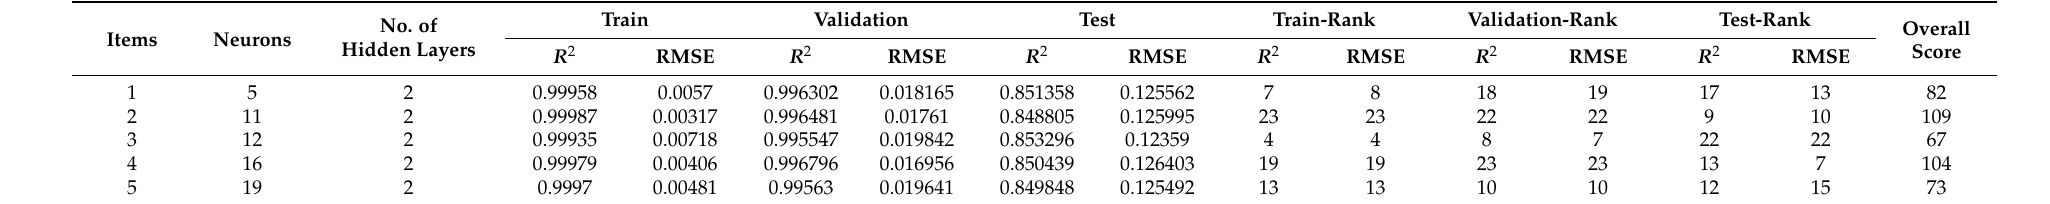
Table 4. Selecting the optimal ANN model with respect to two hidden layer and neurons for the USA